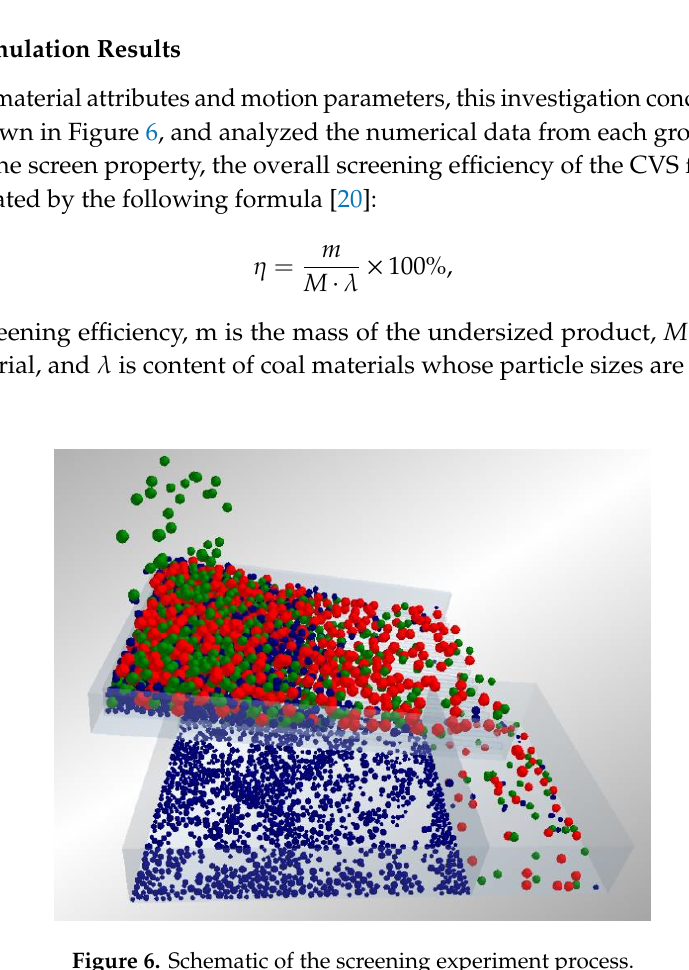
Figure 6. Schematic of the screening experiment process.